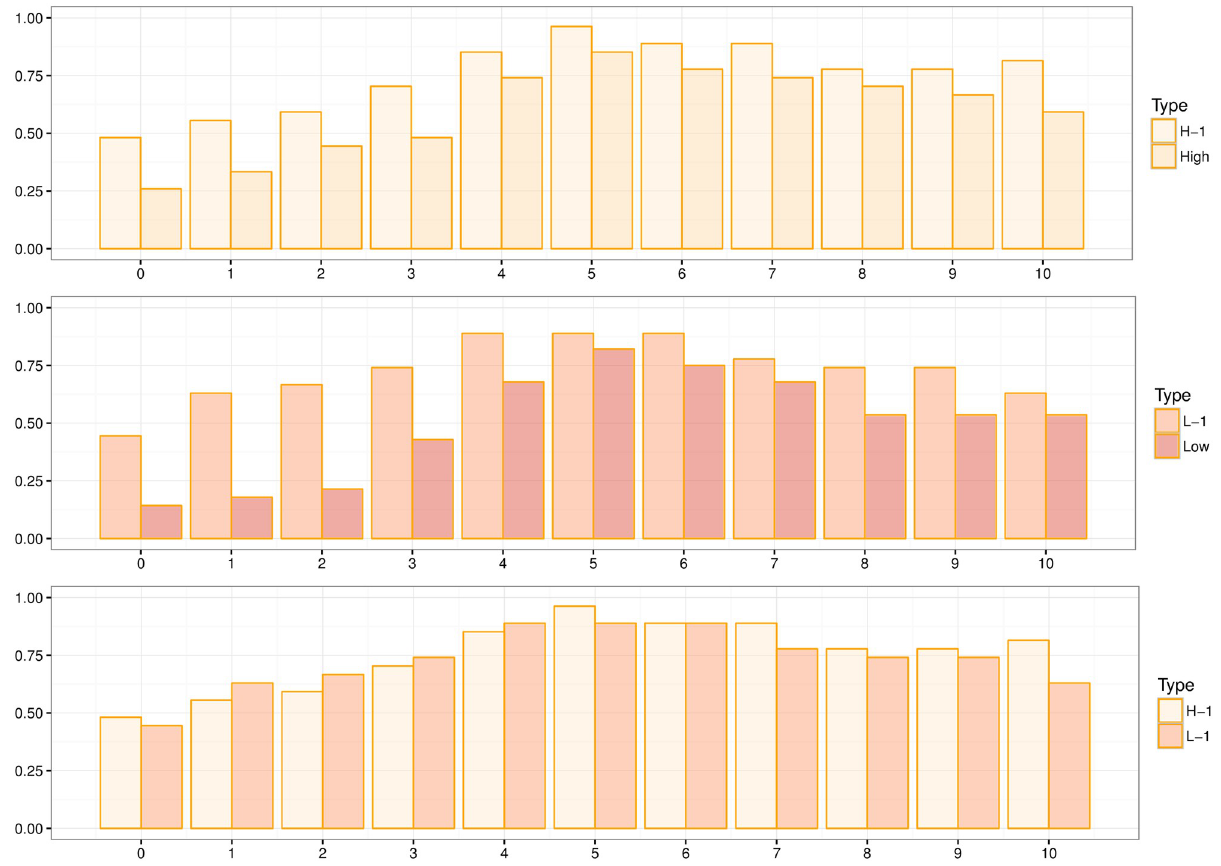
Fig 3. Acceptance rates of L-1 and H-1 plotted against their baseline counterparts and a comparison of L-1 and H-1. For each graph, in the vertical axis we plot the percentage of acceptances, and in the horizontal axis the offer.